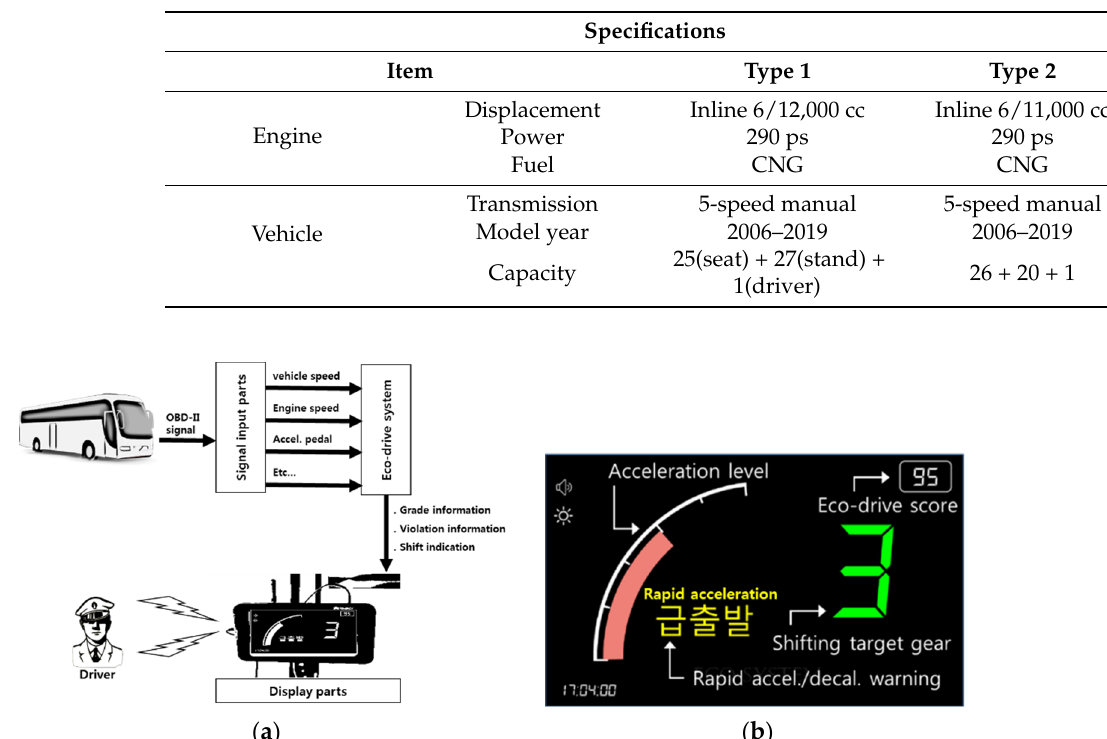
Table 2. Specifications of urban buses.